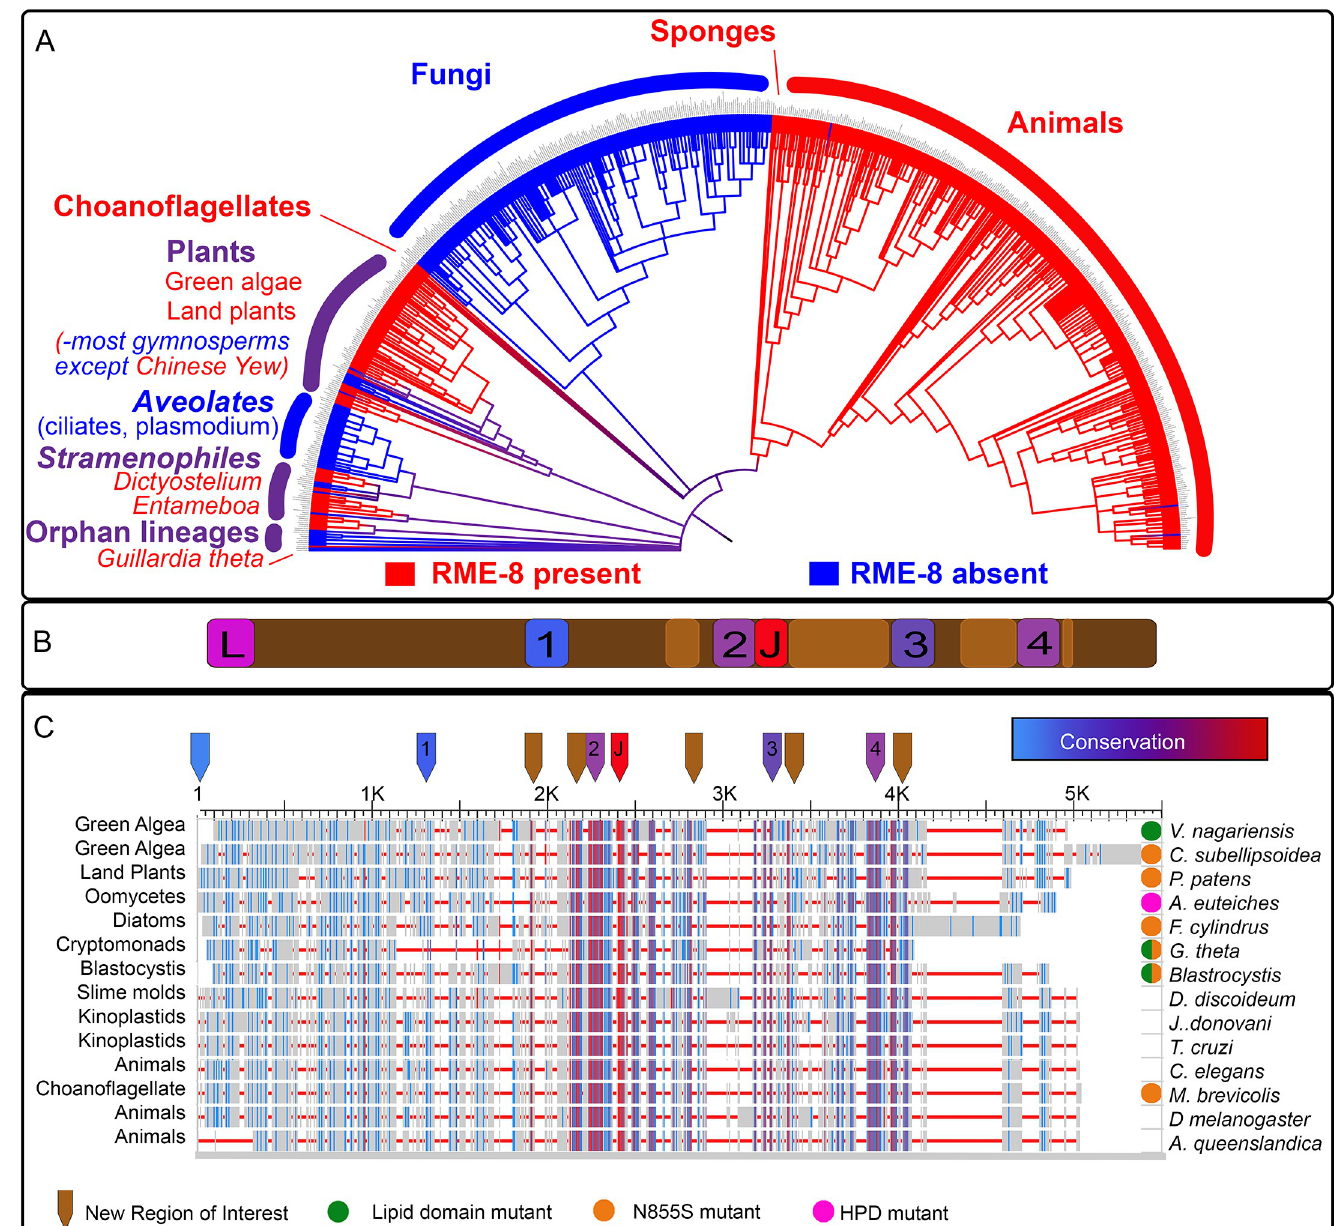
Fig 1. RME-8 homologs are found dispersed throughout Eukarya. (A) A phylogram of Eukarya generated in iTOL, (see methods). Branches containing an RME-8 homolog are indicated in red, nodes containing branches with RME-8 homologs present and absent are colored in purple, and branches or nodes containing no RME-8 homologs are colored in blue. (B) A schematic of RME-8 with key domains indicated with new regions of interest (from the MSA) indicated in light brown and the colors of the IWN domains are in accordance with their conservation as seen n C. Lipid binding domain (L), IWN domains (1–4) and DNAJ (J) are indicated. (C) An alignment of a sampling of RME-8 homologs from dispersed branches in Eukarya generated by the NCBI Multiple Sequence Alignment (MSA) viewer. The names of the phylogenetic categories are indicated to the left, and species names are indicated to the right of the MSA. Colored dots indicating mutations in key domains are indicated to the left of the species name. A pink dot indicates that key residues in the DNAJ domain are mutated. A green dot indicates the key W20 (human) residue in the originally proposed lipid binding domain is absent, and an orange dot indicates the Parkinson’s associated residue N855 (human) is not conserved. In the MSA, red horizontal lines represent gaps, grey bars represent minimal homology, blue bars represent low homology and red indicates high homology. Arrows above the alignment indicate key areas of interest, known regions of interest are colored based on their homology, new regions of interest are indicated by light brown arrows. The colors of the IWN domain arrows are in accordance with their